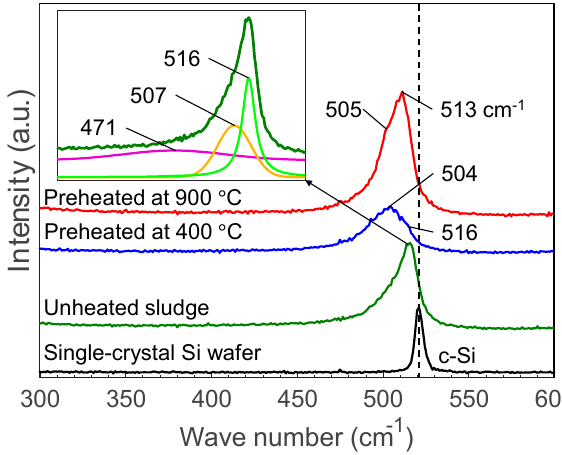
Figure 8. Raman spectra of sludge targets preheated at different temperatures. The insert shows an example of peak separation.